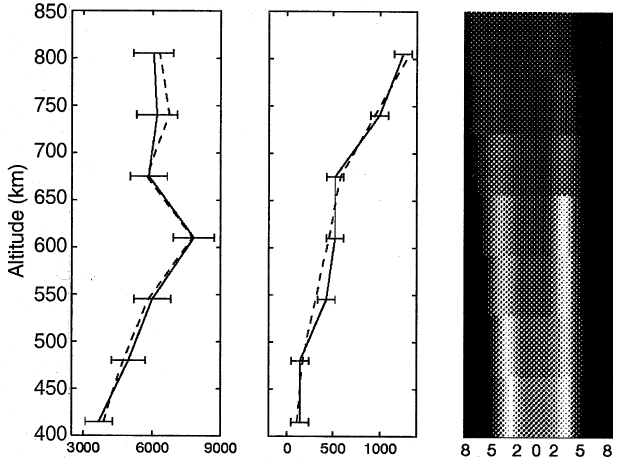
Fig. 6. Same as Fig. 3 at